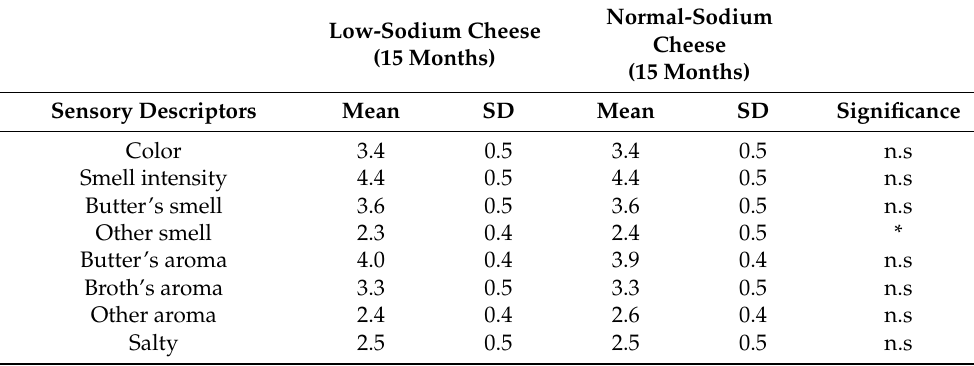
Table 5. Descriptive statistics and t -test significance for 15-month-ripened